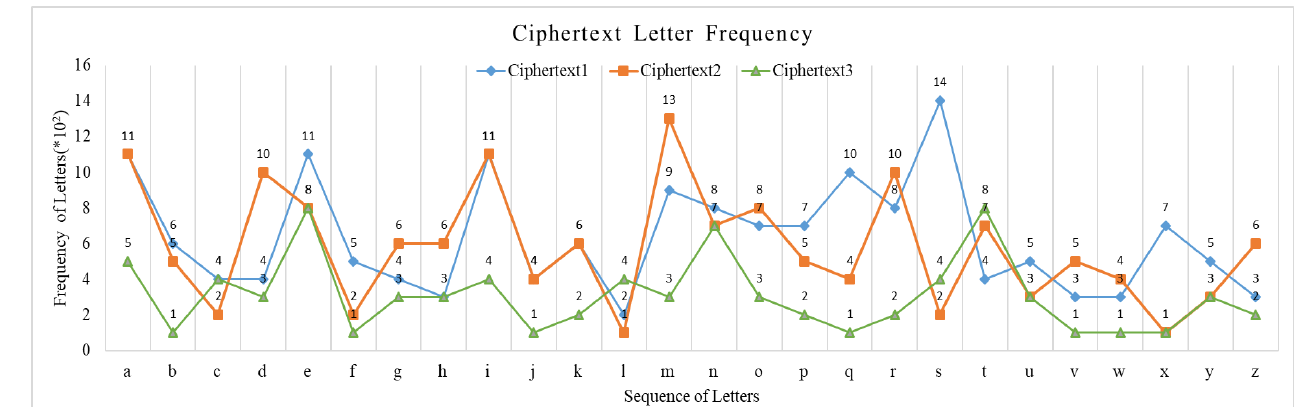
Figure 9 . Ciphertext Letter Frequency Comparison